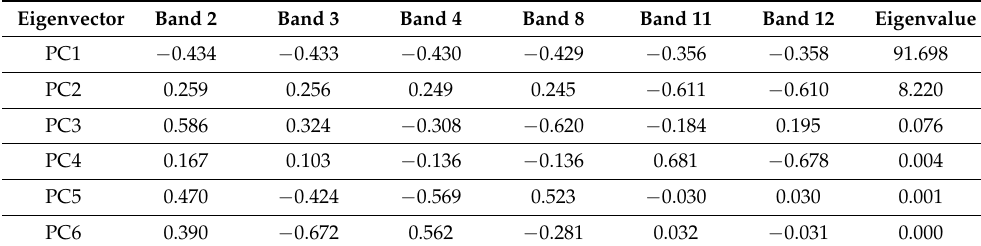
Table 2. PCA analysis of Sentinel-2 data.